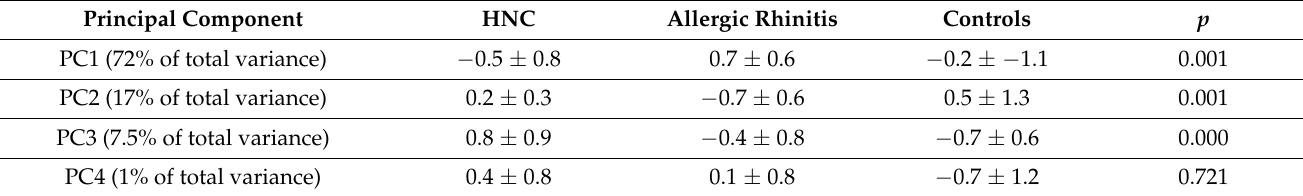
Table 3. ANOVA of the four principal components (PC) among the three